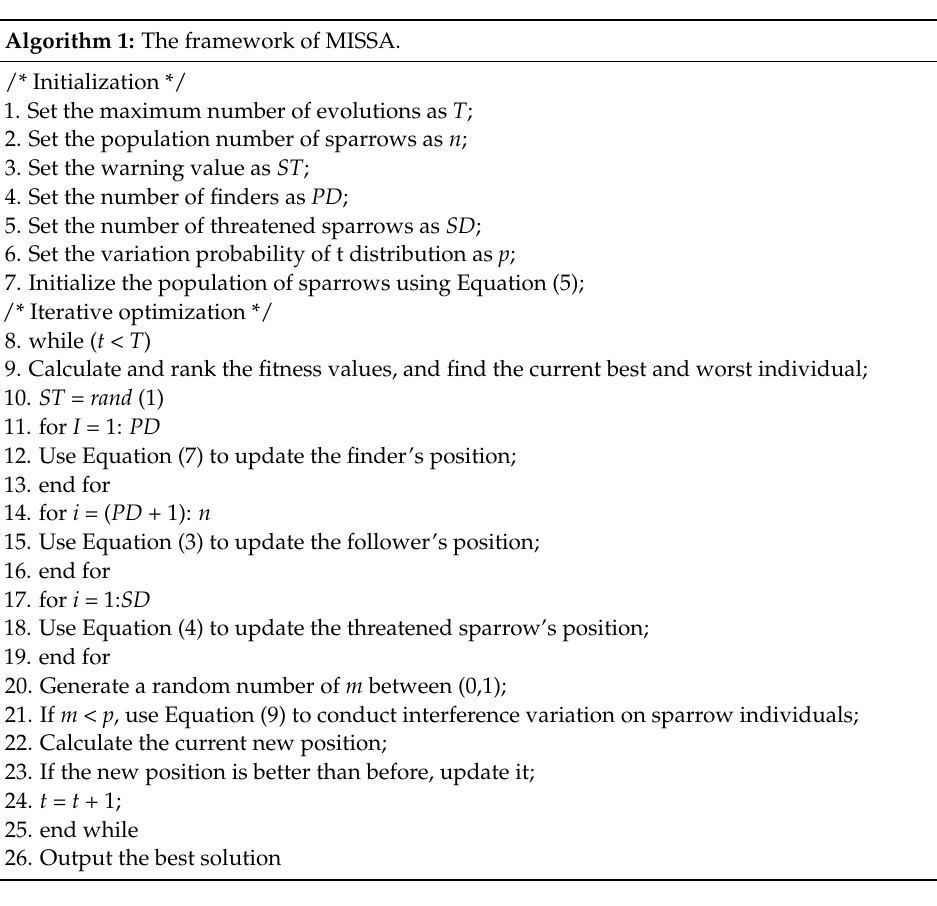
Algorithm 1: The framework of